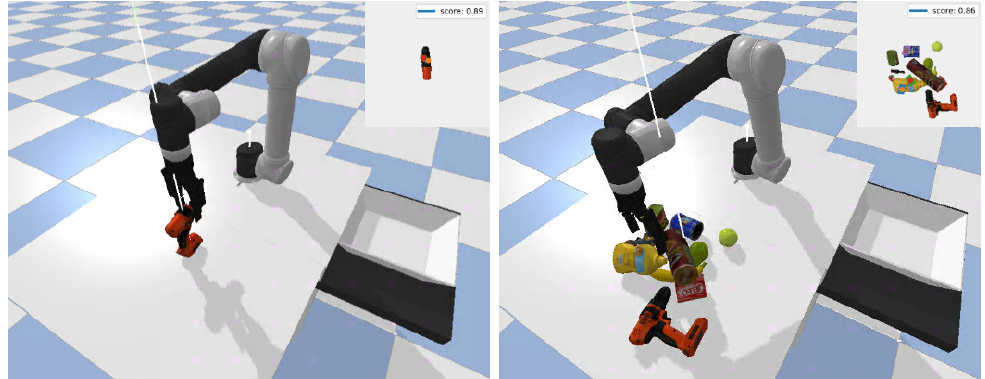
Figure 11. Examples of antipodal grasping in simulation. ( Left ) Grasping YCB objects in isolation. ( Right ) Grasping YCB objects in clutter.